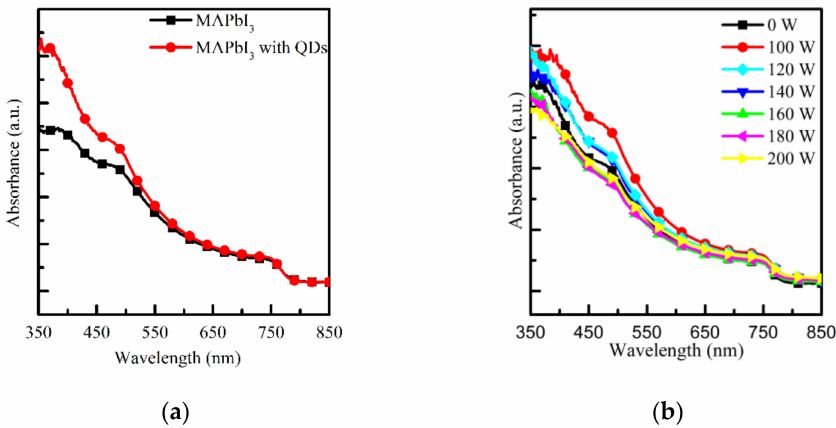
Figure 2. Absorbance of UV–visible light spectra of perovskite film ( a ) MAPbI 3 and MAPbI 3 compos- ite with QDs without APT ( b ) MAPbI 3 composite with QDs treated by APT at different powers.